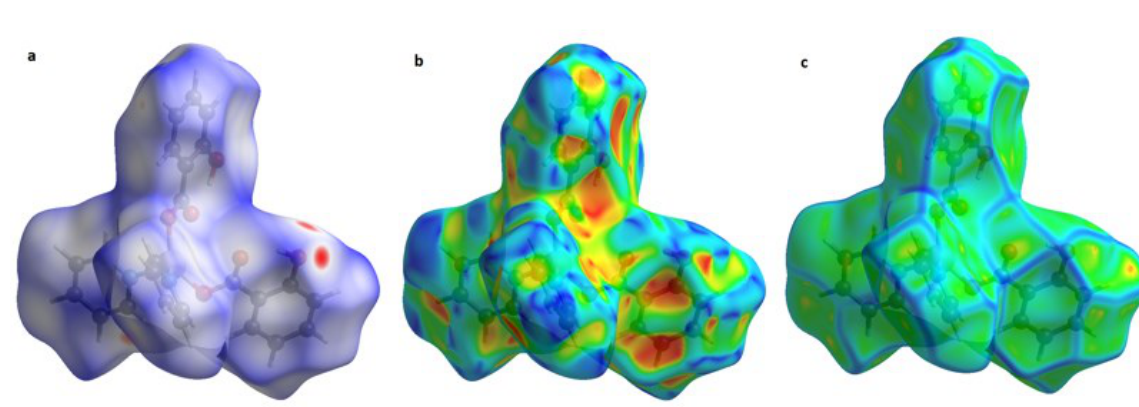
Fig. S1. Hirshfeld surface of molecule2 a) plotted over d +1.520 arbitrary units; b) plotted over shape- index property (range from −1.000 to 1.000), and c) plotted over curvedness (range from −4.000 to